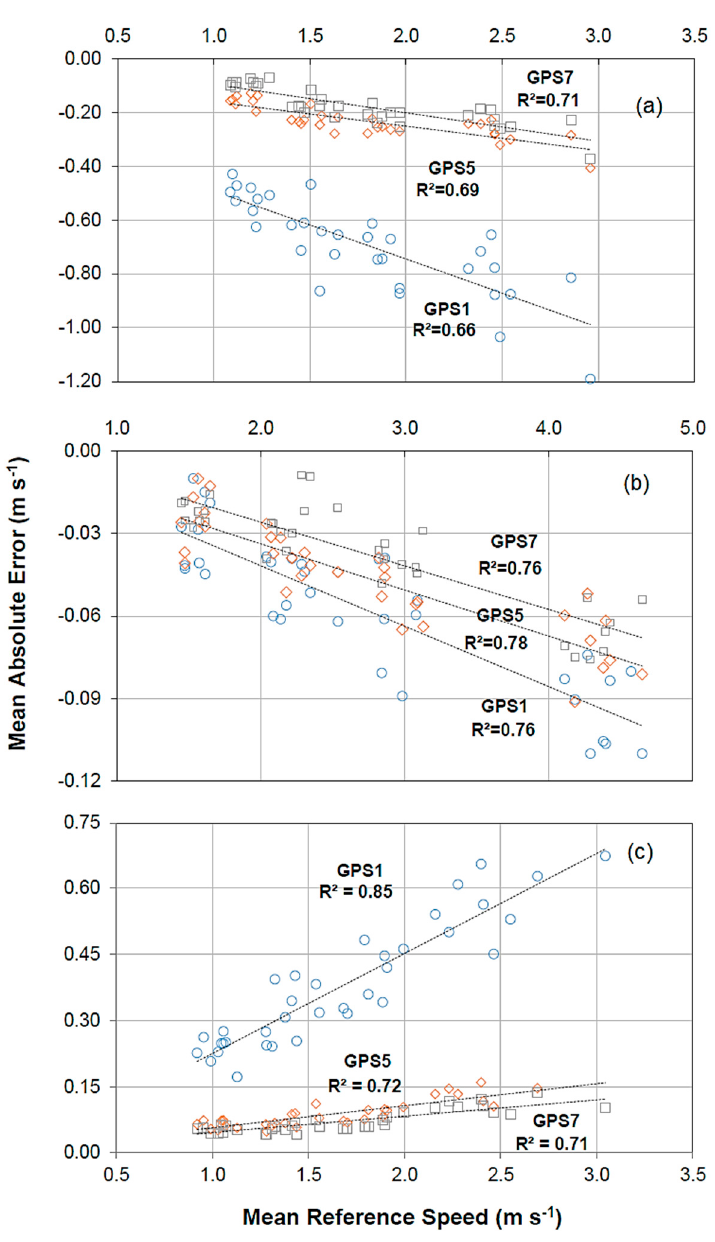
Figure 6. Mean absolute speed errors of the three GPS speed sensors at increasing ( a ), constant ( b ) and decreasing ( c ) speed conditions (different scales were used for y -axis).